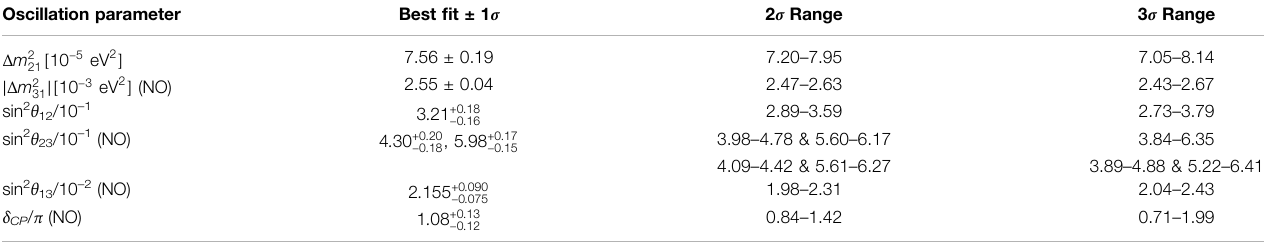
TABLE 2 | Global- fi t values of the oscillation parameters along with their 1 σ , 2 σ , and 3 σ ranges [77 – 79]. Oscillation parameter